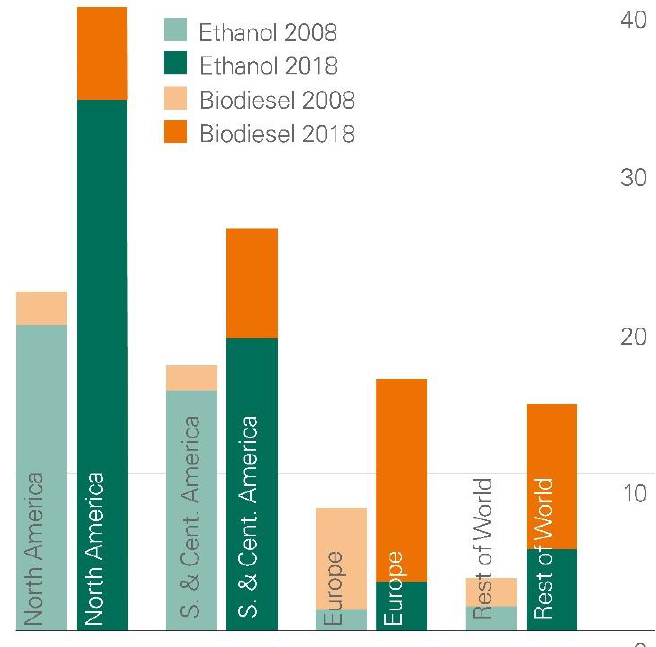
Figure 3. World ethanol and biodiesel production from 2008 to 2018 (vertical axis in million tonnes oil equivalent) [2]. Table 1. Biodiesel production from different feedstocks in Portugal (adapted from [13]).